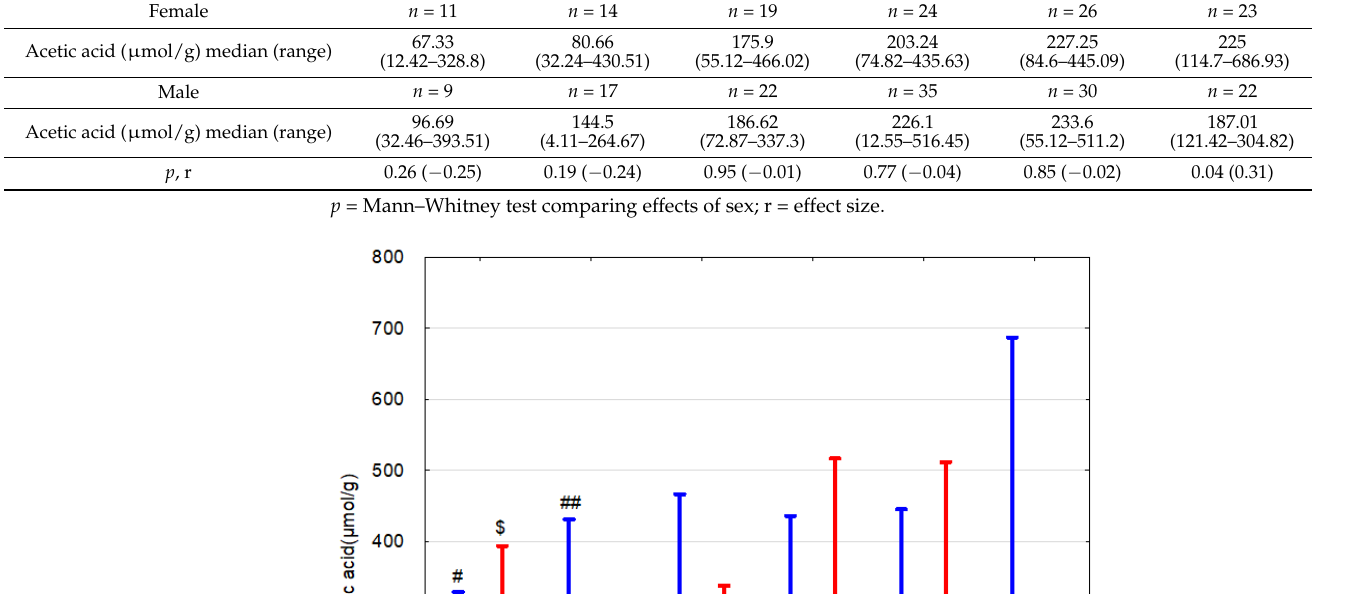
Table 10. Summary of the multivariable and univariable analyses of SCFAs.